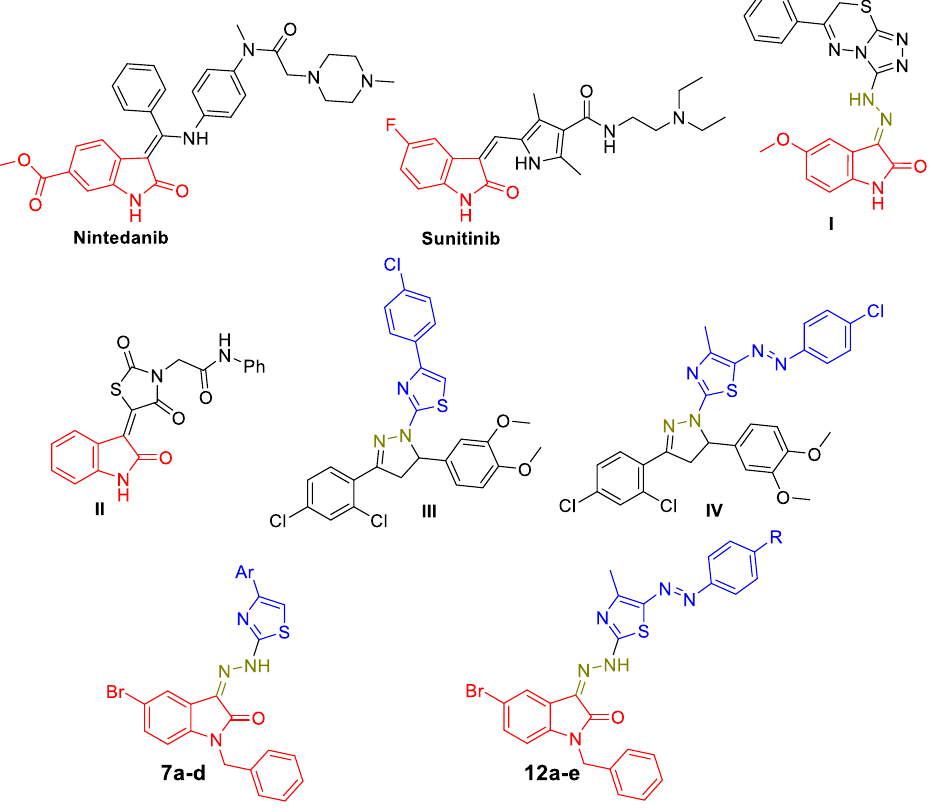
Figure 1. Structure of Nintedanib, Sunitinib, VEGFR-2 inhibitors ( I – IV ), and target molecules ( 7a – d and 12a – e ).